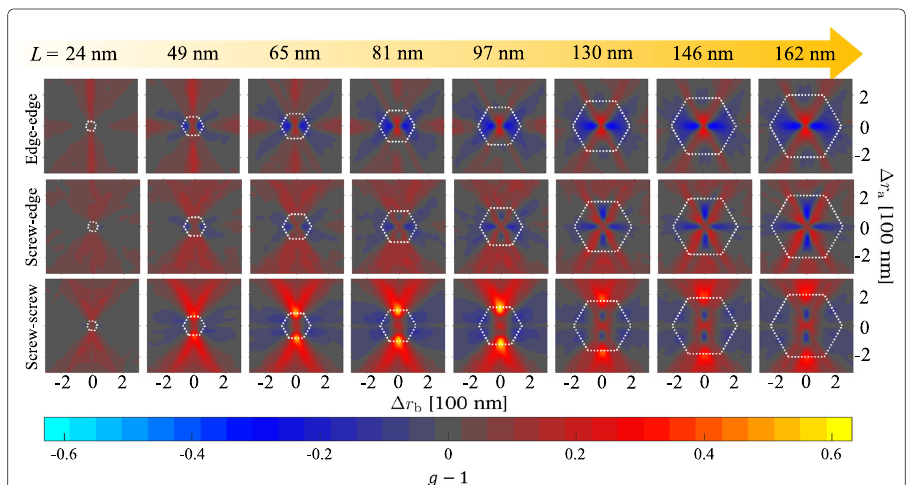
Fig. 3 Dependence of the correlation tensor on the convolution length. All correlations shown are calculated from the 45 configurations at 0.30% strain, and the correlations are relative to a “discrete density” which is calculated with a 16 nm convolution length. The rows show the edge-edge, screw-edge, and screw-screw components of the correlation function and the columns demonstrate progressively longer correlation lengths. All figures show the correlation on the same color scale and relative to the same spatial dimensions. For reference, the border of the coarse averaging region (the support of w L ) is also shown as a hexagon, the intersection of the box with {111} type